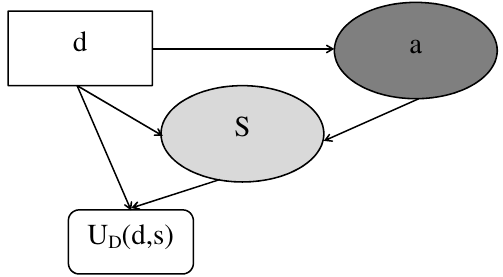
Figure 14. Defender’s ID for the ARA defend-attack